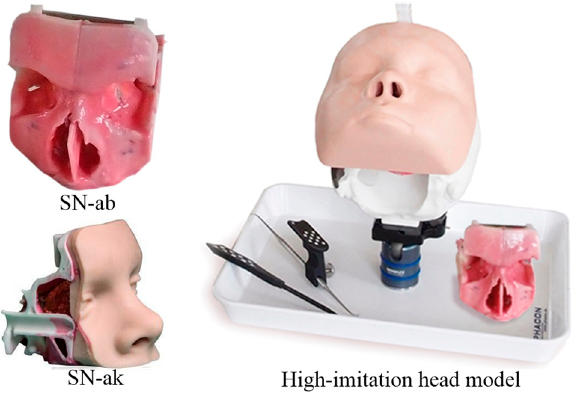
Figure 14. High-imitation head model with fine anatomical structure of the nasal sinus. ( a ) Nasal cavity module; ( b ) high-imitation head